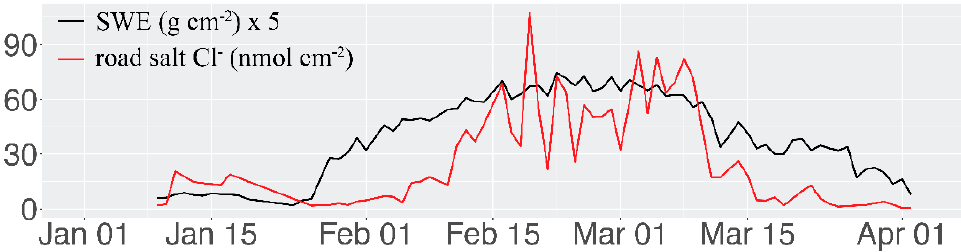
Figure 4. A comparison of total snowpack road salt Cl − and SWE during Winter 3 at BDO. Cl − data has been interpolated over missing data points in the time series.